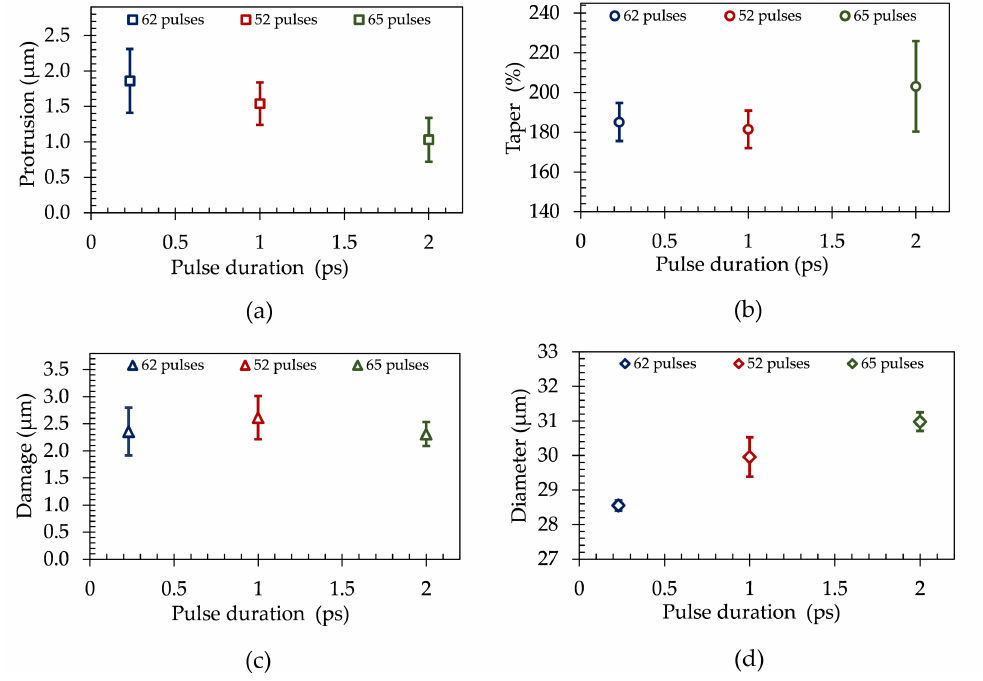
Figure 5. ( a ) Glass fiber protrusion, ( b ) taper, ( c ) damage in inner copper layer and ( d ) diameter of 10 laser drilled microvias in FR-4 PCB material depending on the laser pulse duration of τ = 0.23, 1 and 2 ps using a laser pulse repetition rate of f = 50 kHz, a laser pulse energy of E = 10 µJ and a number of laser pulses between 52 and